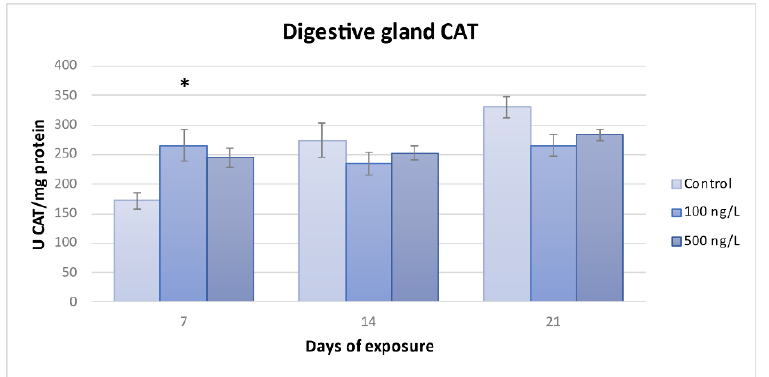
Figure 4. Catalase activity in the digestive gland of Ruditapes philippinarum after exposure for 7, 14 and 21 days to 100 ng/L and 500 ng/L of HHCB. The results are expressed as U/mg of proteins and are reported as means ± standard error; n = 6. Asterisks indicate significant differences compared to controls at the same time of exposure: * p < 0.05.